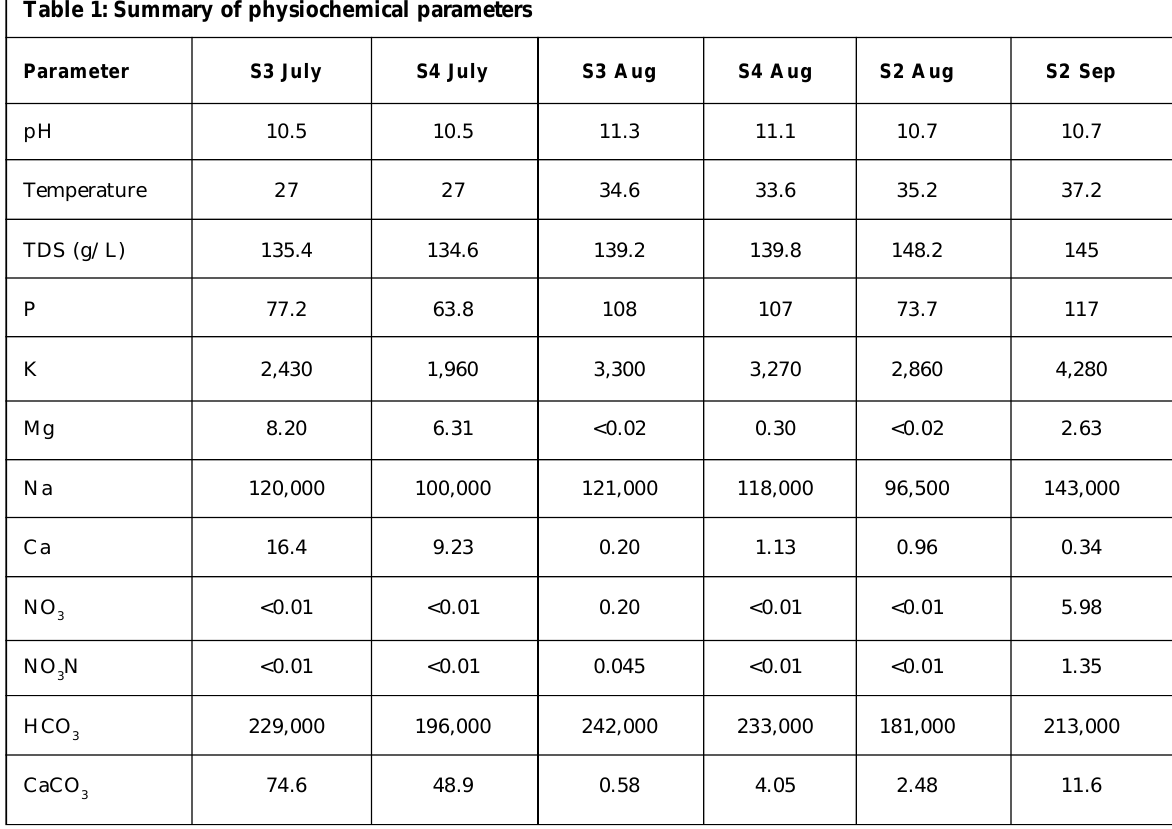
Table 1: Summary of physiochemical parameters